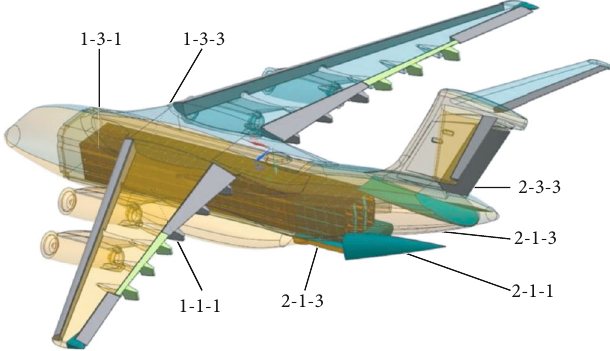
Figure 6: Examples of missile loading position labels. Table 1: Experiment and FEM simulation results of missile